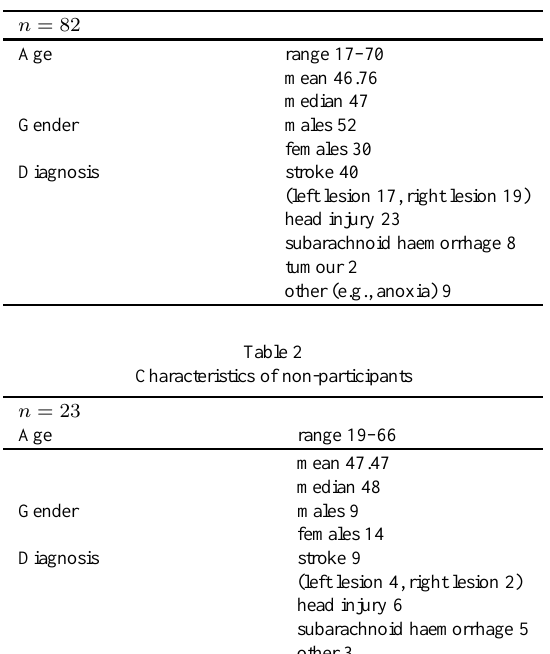
Table 1 Characteristics of Sample